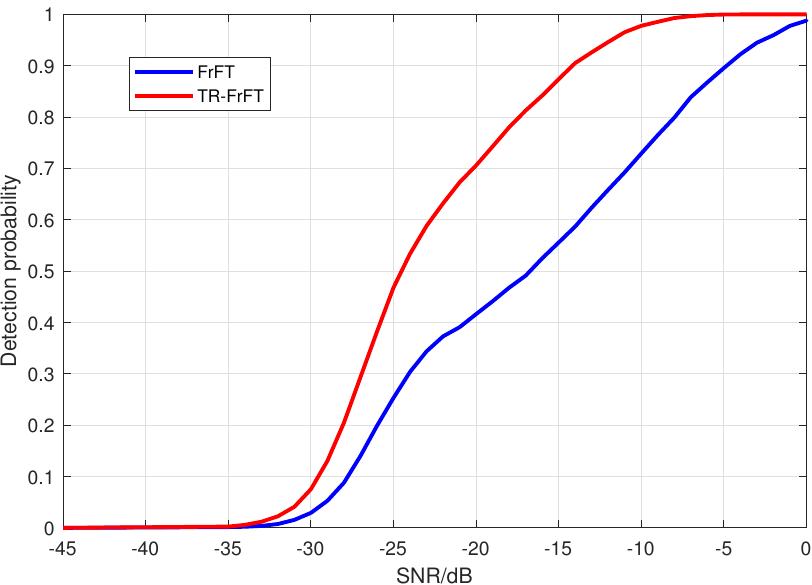
Figure 15. Detection probability vs. SNR for FrFT and TR-FrFT with the simulated data. The false alarm rate is P F = 0.1. The Doppler frequency shift is 40 Hz.